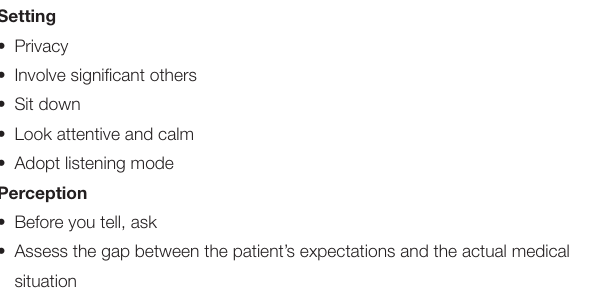
TABLE 2 | Most common adjustment described in the literature of cardiovascular drugs in patients with advanced heart failure in need of palliative